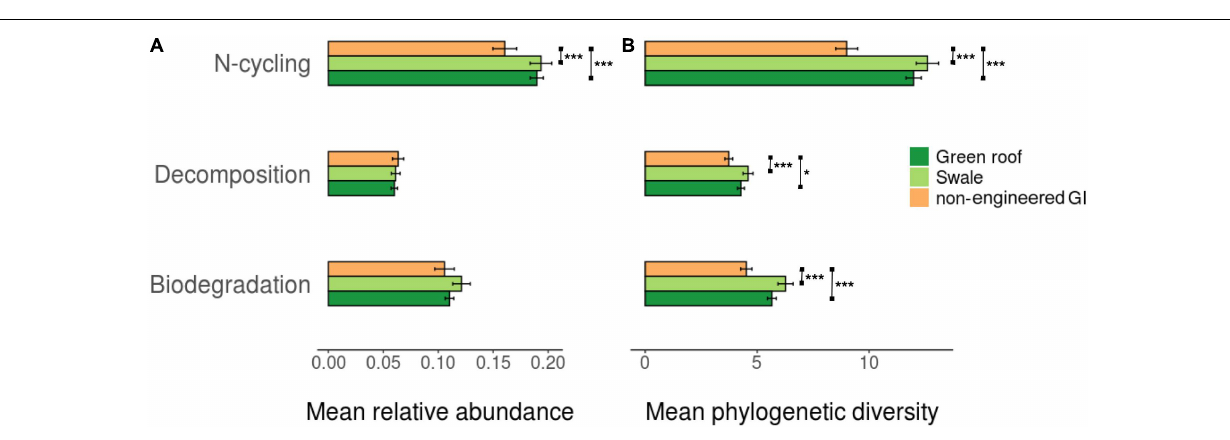
FIGURE 5 | Average relative abundance (A) and phylogenetic diversity (B) for trait-associated bacterial variants (* p < 0.05, ** p < 0.01, *** p <